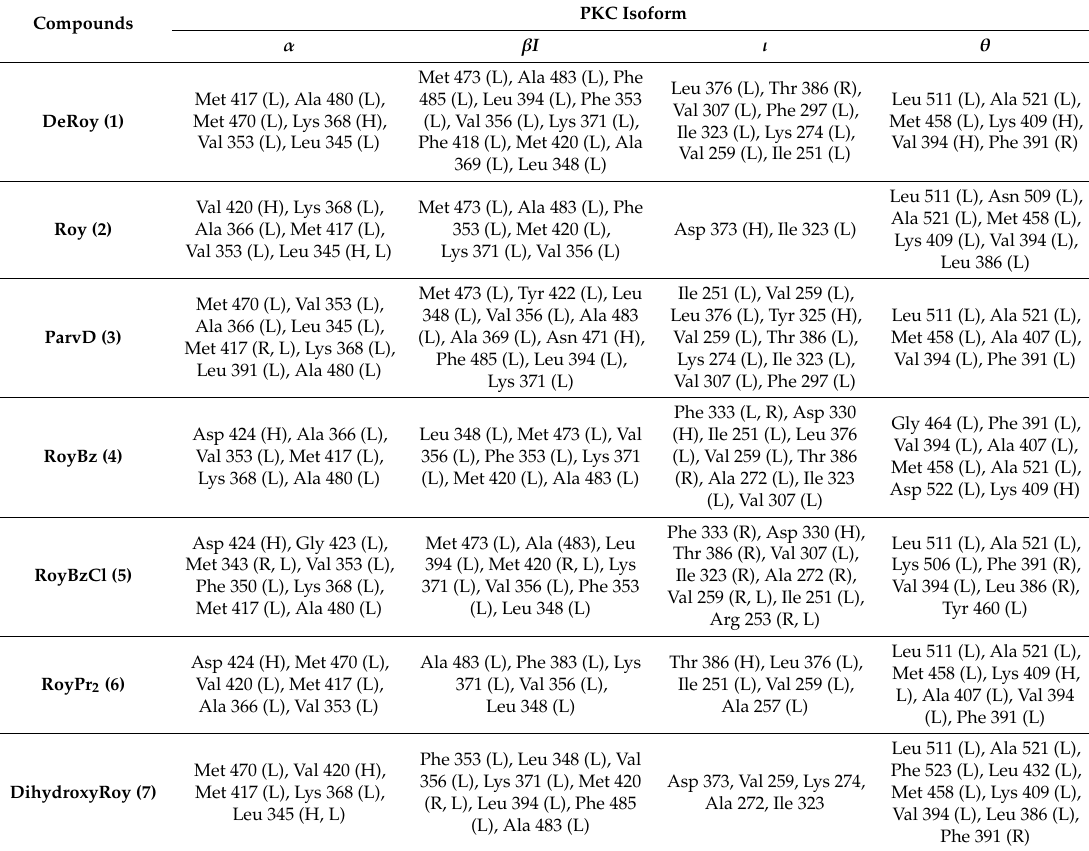
Table 3. PKC isoform binding site amino acids and corresponding interactions.